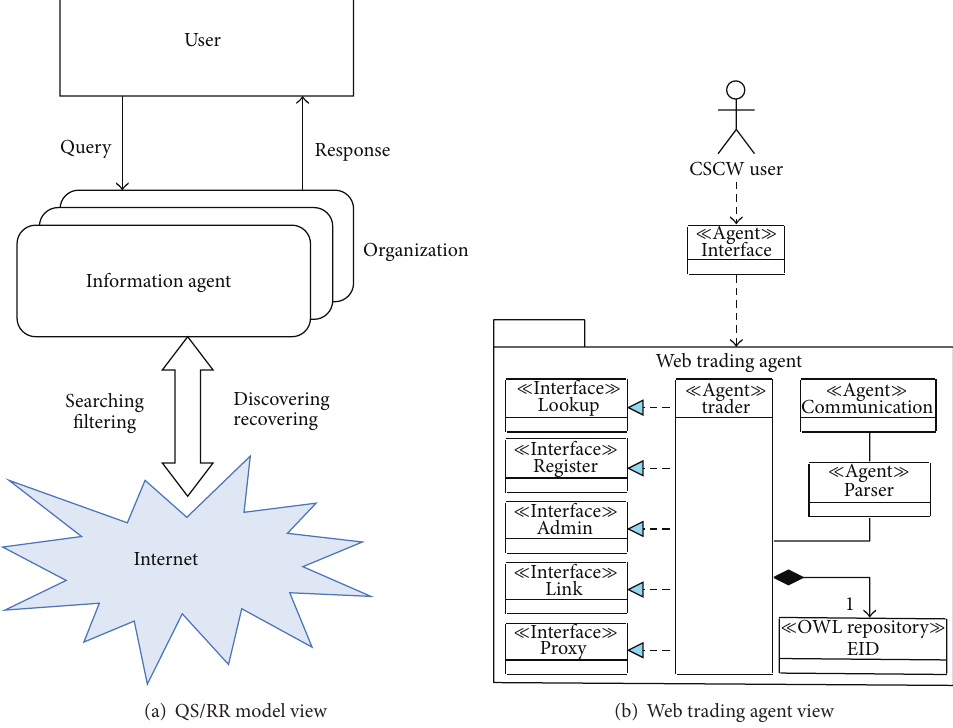
Figure 3: The web trading agent (b) uses the QS/RR model